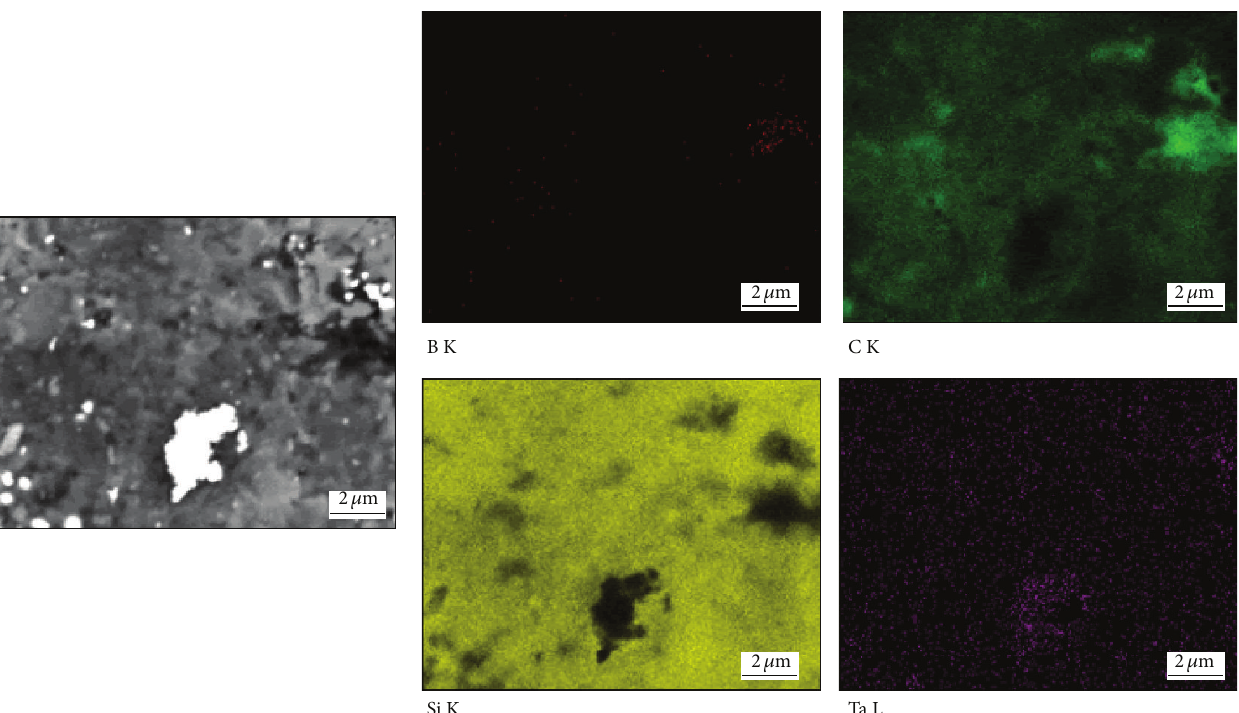
Figure 2: EDS mapping of the distribution and intensity of elements over the scanned area of the sintered